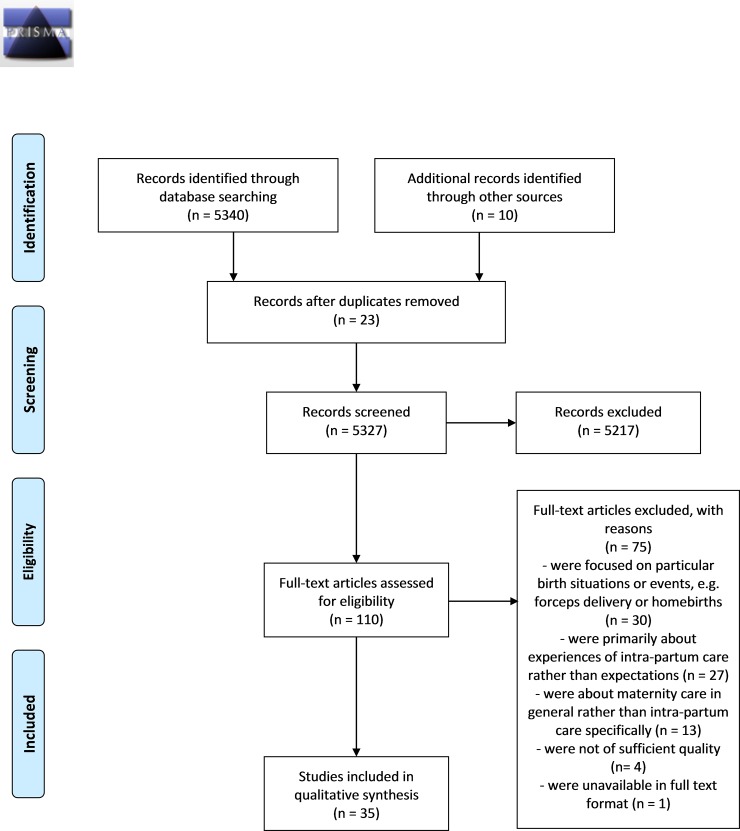
PRISMA flow diagram.